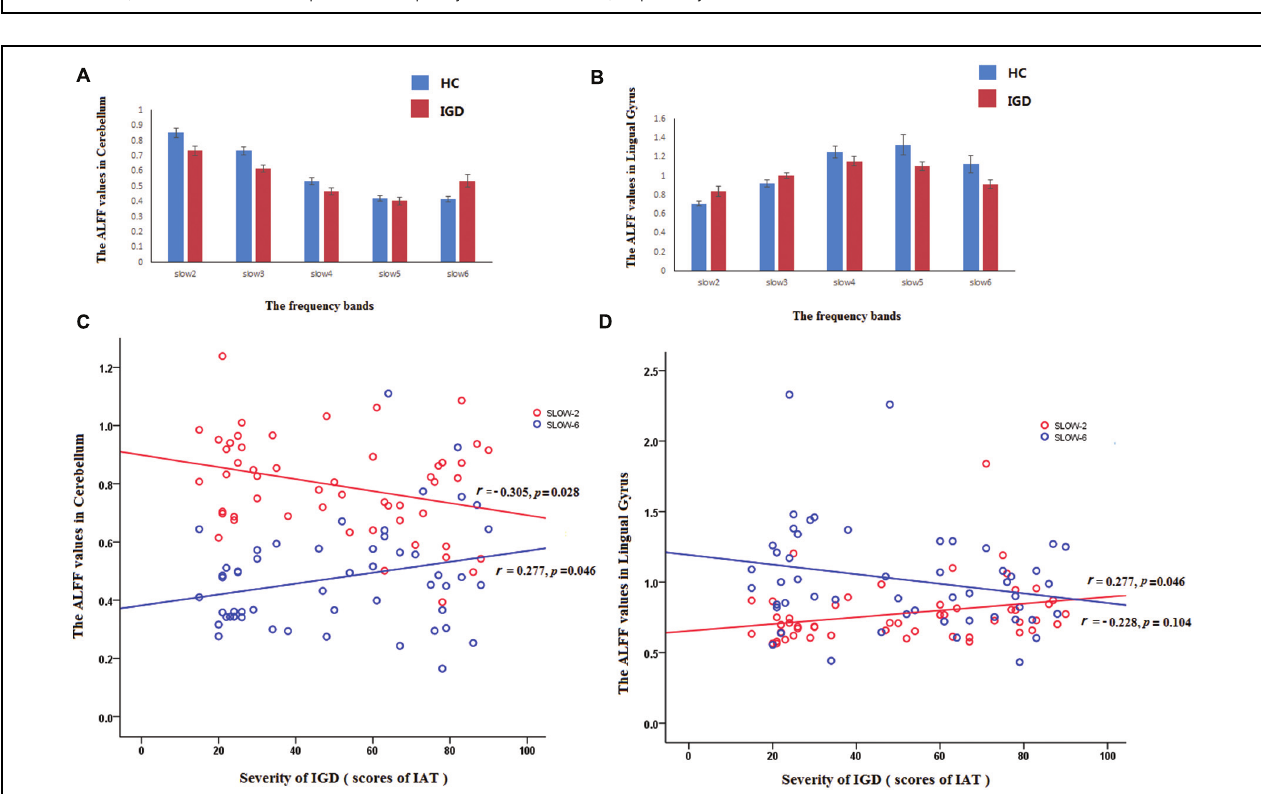
FIGURE 3 | Reverse pattern in cerebellum and the lingual gyrus at different bands in IGD. The red and blue rectangle represented IGD subjects and healthy controls, respectively. The full frequency band (0–0.25 Hz) was divided into five bands. They were displayed in (A,B) [slow-6 (0–0.01 Hz), slow-5 (0.01–0.027 Hz), slow-4 (0.027–0.073 Hz), slow-3 (0.073–0.198 Hz), and slow-2 (0.198–0.25 Hz)]. (C) revealed the reversed correlation between the fALFF of the cerebellum and the severity of IGD for different frequency (slow-2: r = − 0.305, p = 0.028; slow-6: r = 0.277, p = 0.046), (D) revealed the reversed correlation between the fALFF of the lingual cyrus and the severity of IGD for different frequency (slow-2: r = 0.277, p = 0.016; slow-6: r = − 0.228, p = 0.104).